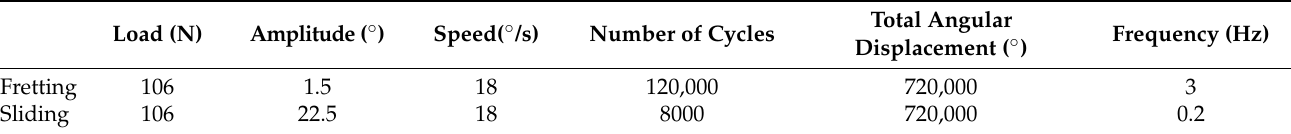
Table 1. Fretting and sliding test